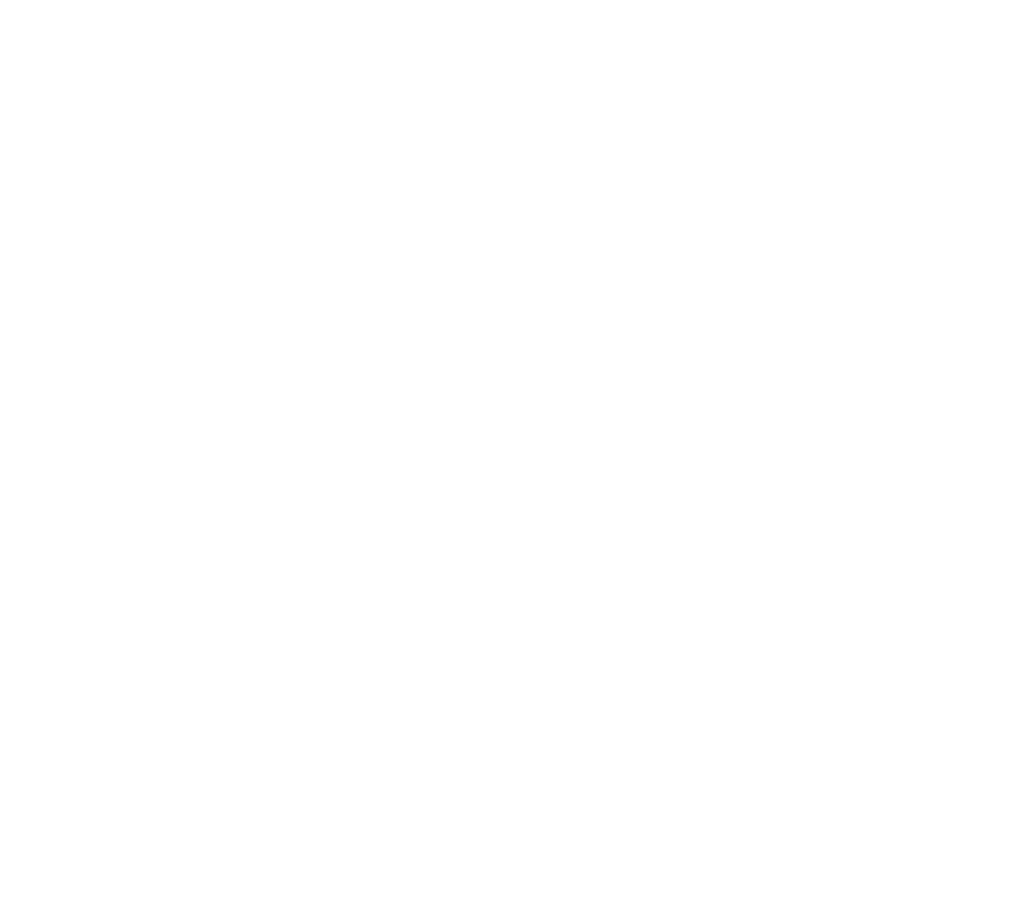
Figure 2 Partition of positive BAC across 5 BAC levels: ≤1, >1 to ≤2, >2 to ≤3, >3 to ≤4, >4 permille (g of ethanol per liter of blood). BAC: blood alcohol concentration Note: The percentage of subjects in each category is indicated in the